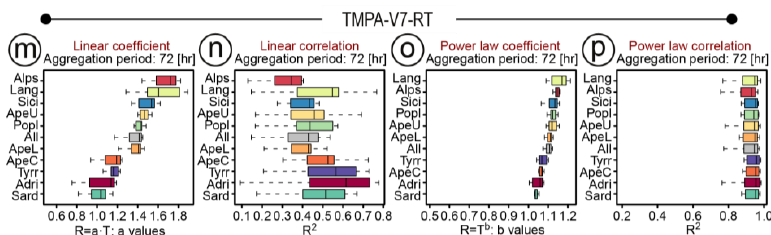
Figure 9. Variability of the linear coefficients ( a , e , i , m ) and the relative determination coefficients ( b , f , j , n ), and the power-law coefficients ( c , g , k , o ) and the relative determination coefficients ( d , h , l , p ) for different rainfall thresholds values (see Figures 5–8) in the entire Italian territory and in the different morphological subdivisions (see Table 2 and Figure 1).